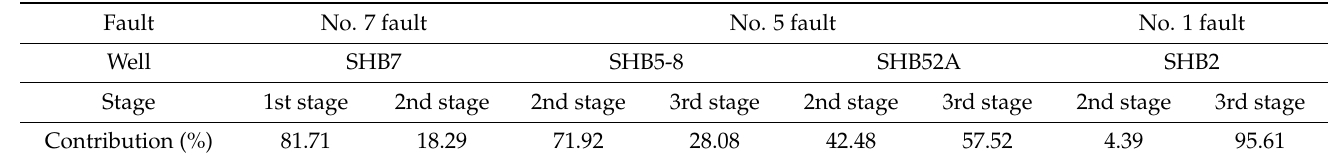
Table 3. Comparison of hydrocarbon accumulation contribution of Ordovician strike-slip fault zones in the Shunbei